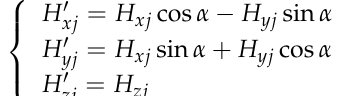
where − π ≤ α ≤ π , and for a magnetic target with a fixed direction of movement, α is a fixed